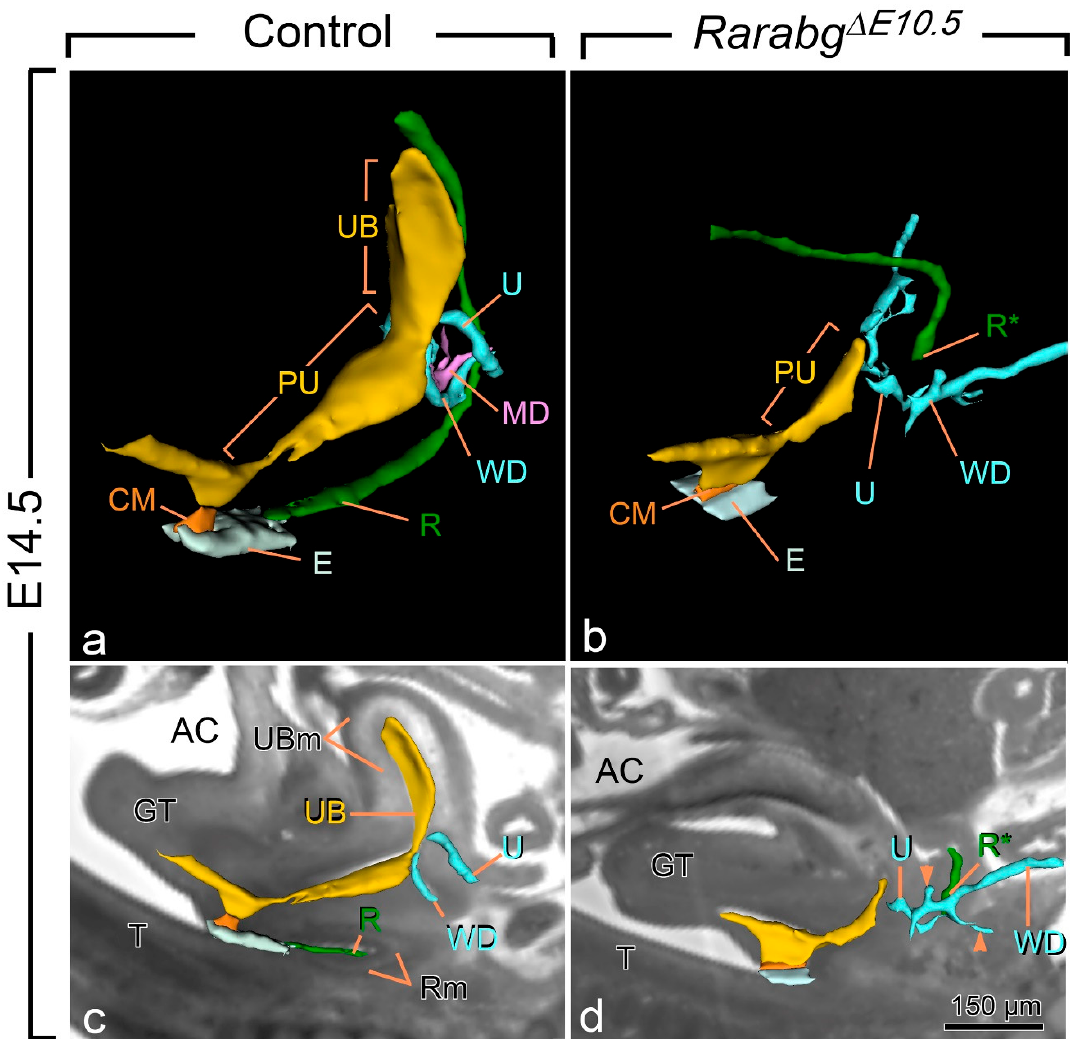
Figure 2. Three-dimensional reconstructions of the rectum and posterior portion of the urogenital tract in a control ( a , c ) and a Rarabg ∆ E10.5 mutant ( b , d ) foetus at E14.5. ( a , b ) Ventrolateral views of the left side and ( c , d ) projections of left lateral views on sagittal HREM sections. ( a , c ) In the control foetus, the urogenital sinus comprises 2 distinct portions: the urinary bladder (UB), which is located anterior to the openings of the ureters (U), and the pelvic urethra (PU) into which the Wolffian ducts (WD) terminate. The pelvic urethra communicates with the amniotic cavity (AC) at the site of disintegration of the cloacal membrane (CM). The rectum (R) is continuous with the tip of the ectodermal groove (E) located between the genital tubercle and the tail. ( b , d ) In the mutant foetus, the rectum ends blindly (R*) at a distance from the ectoderm; the urogenital sinus is markedly hypoplastic and lacks the portion corresponding to the urinary bladder. Neither the ureters nor the Wollfian ducts make contact with the urogenital sinus, and the Wolffian ducts give rise to irregular outgrowths (arrowheads in d ) corresponding to supernumerary ureteric buds; the Müllerian duct (MD) is missing. GT, genital tubercle; R and Rm, lumen and mesenchyme of the rectum, respectively; T, tail; UB and UBm, lumen and mesenchyme of the urinary bladder, respectively. Same magnifications in ( a , b ) and in ( c , d ). Scale bar in ( d ): 150 µm ( c , d ).